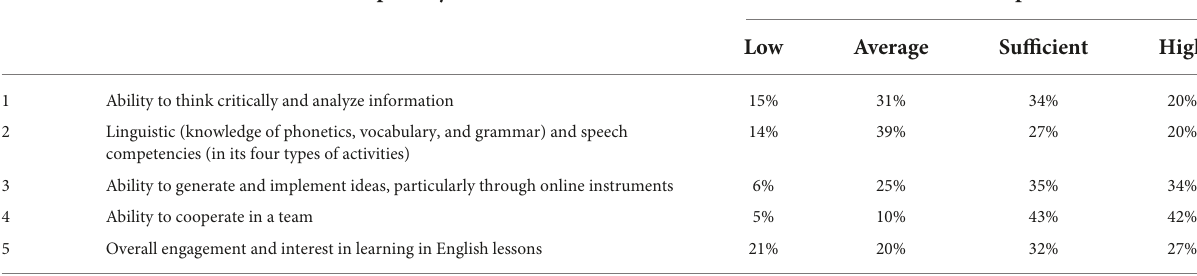
TABLE 2 Levels of students’ competencies at the ascertaining